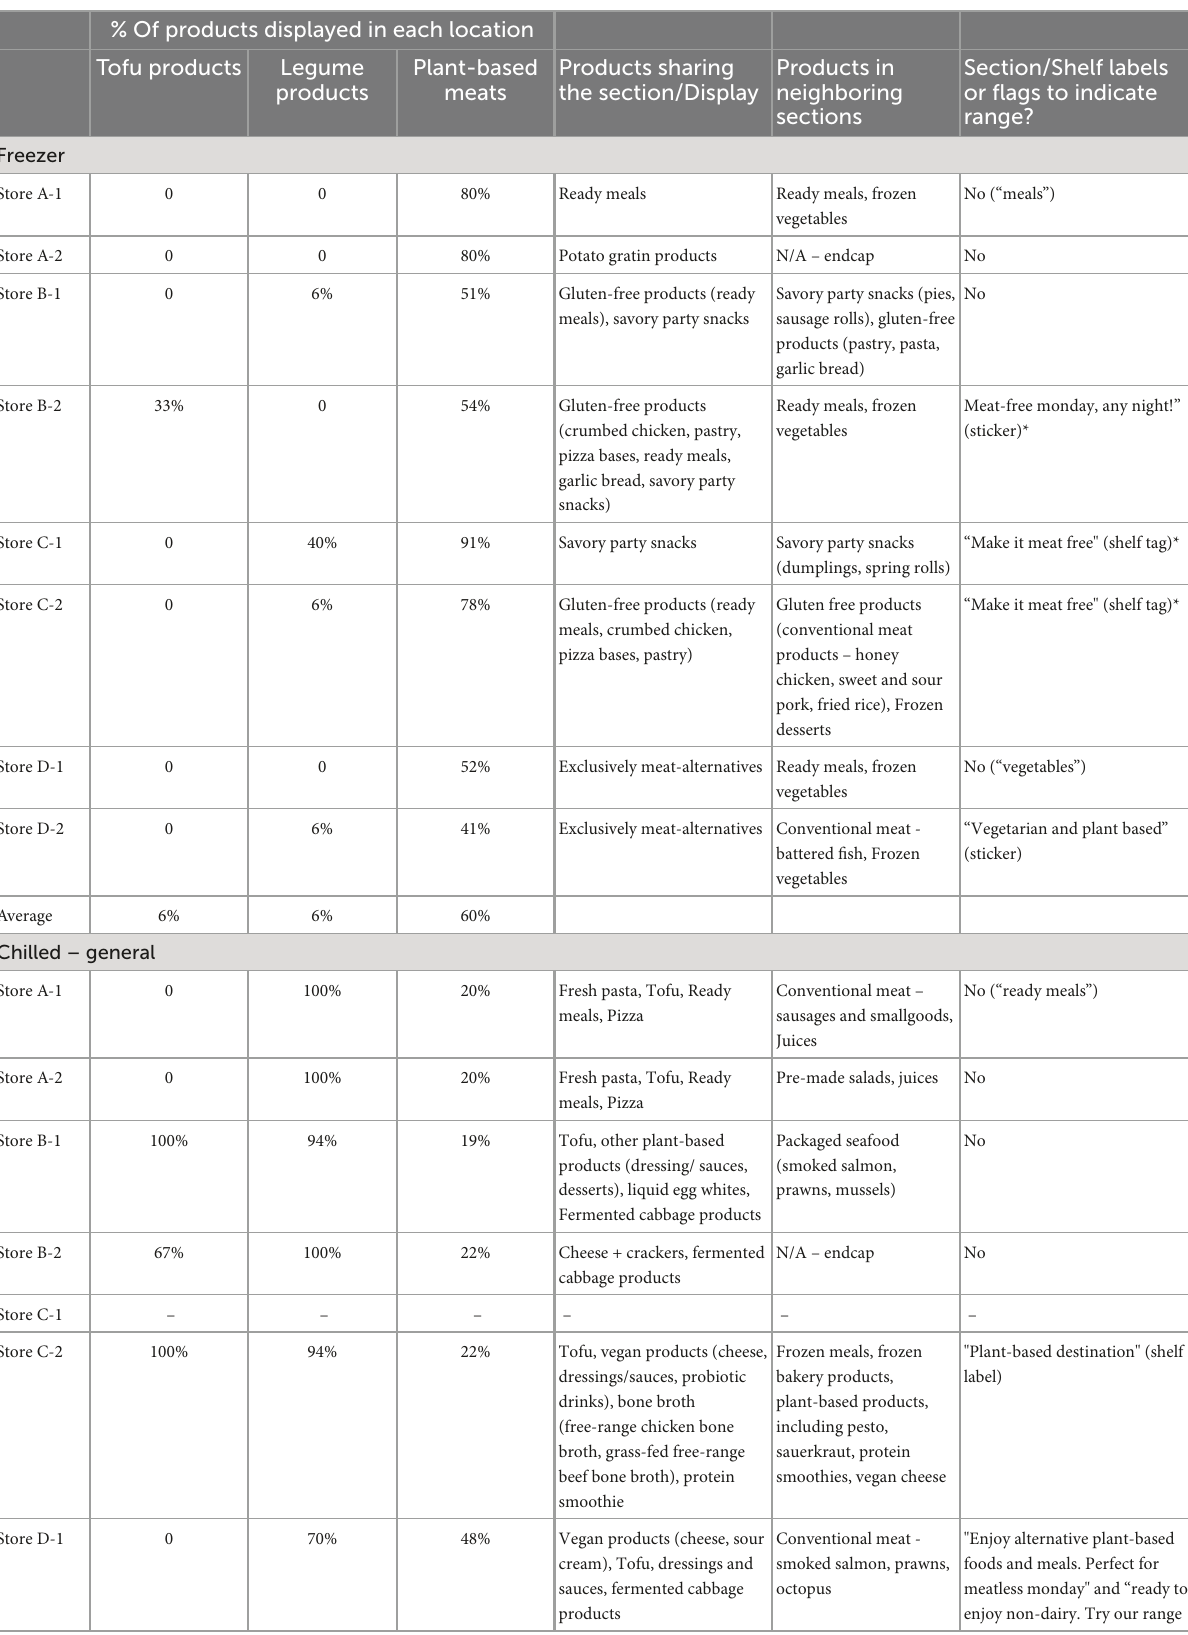
TABLE 7 Location of products from each category within eight different supermarket locations. % Of products displayed in each